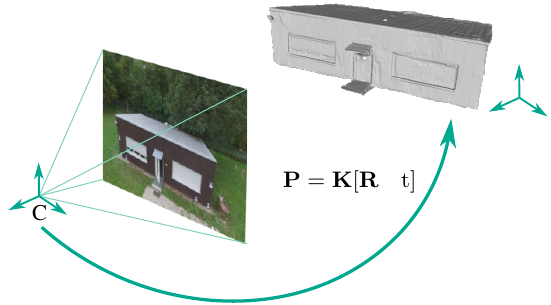
Figure 1. Registration task: Estimation of camera parameters, which describe the relative pose between image and